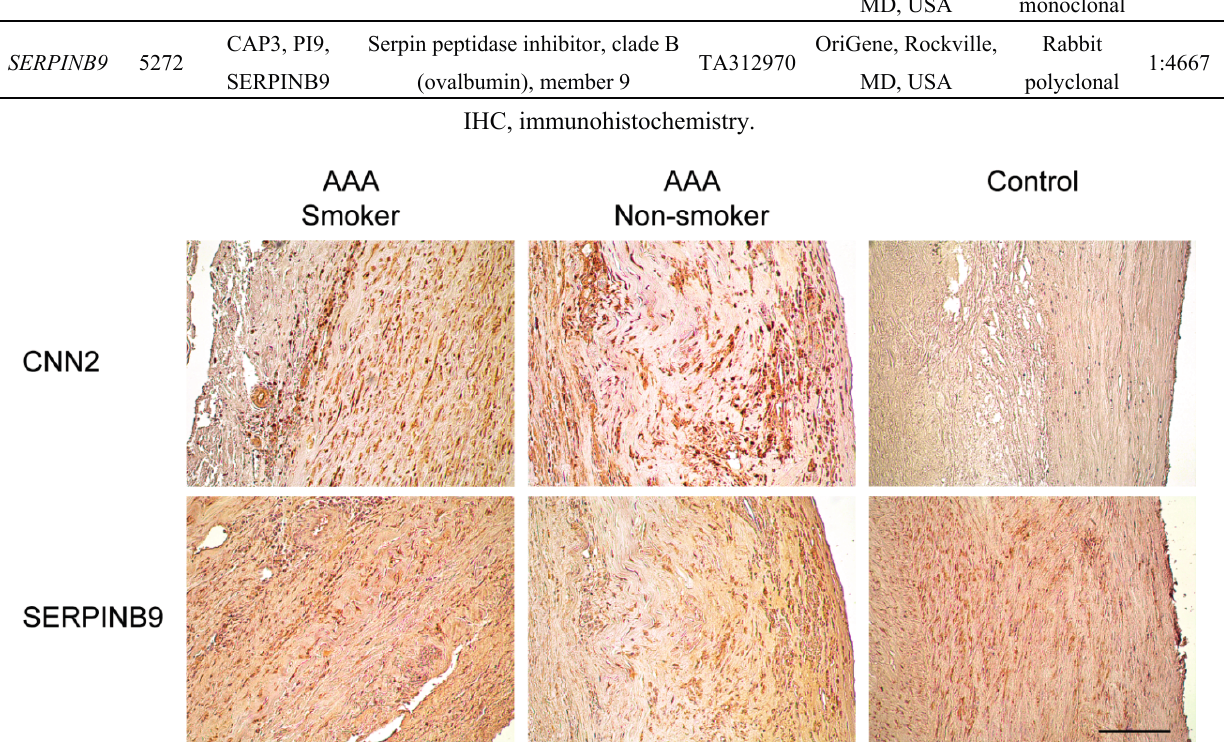
Figure 3. Immunohistochemical staining for CNN2 and SERPINB9 in human aneurysmal and non-aneurysmal abdominal aorta. See Tables 2 and 5 for details on the aortic tissues and antibodies used, respectively. Scale bar = 100 μ